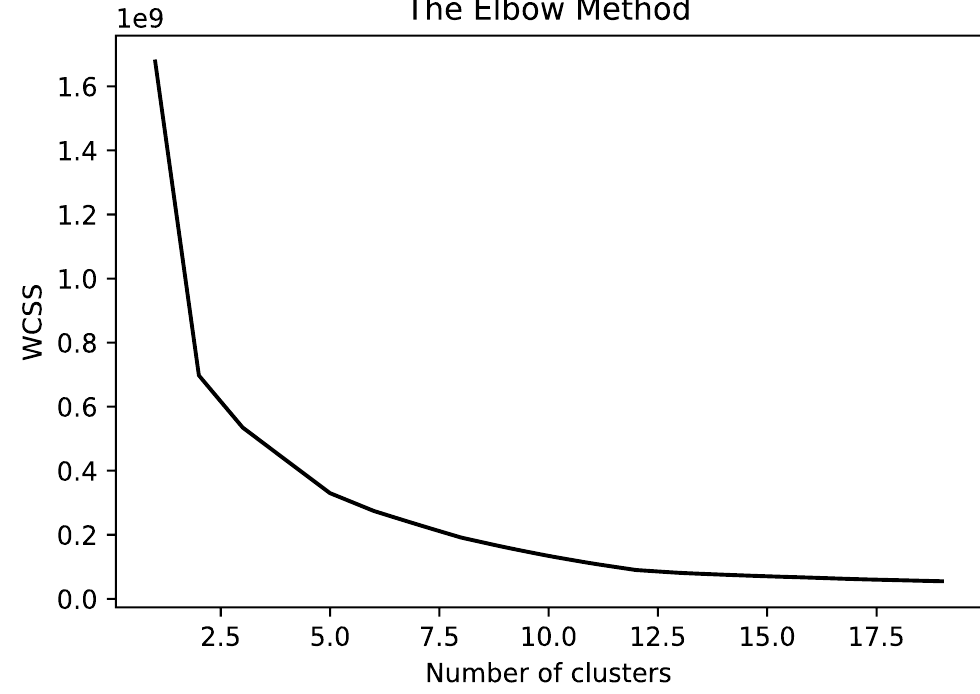
Figure 5. Elbow method to select number of